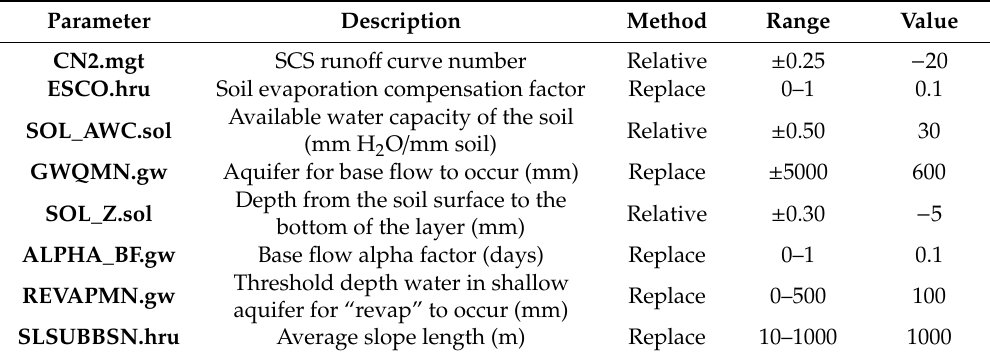
Table 3. Most sensitive SWAT model parameters and their range of adjustment for the Santa Catalina stream